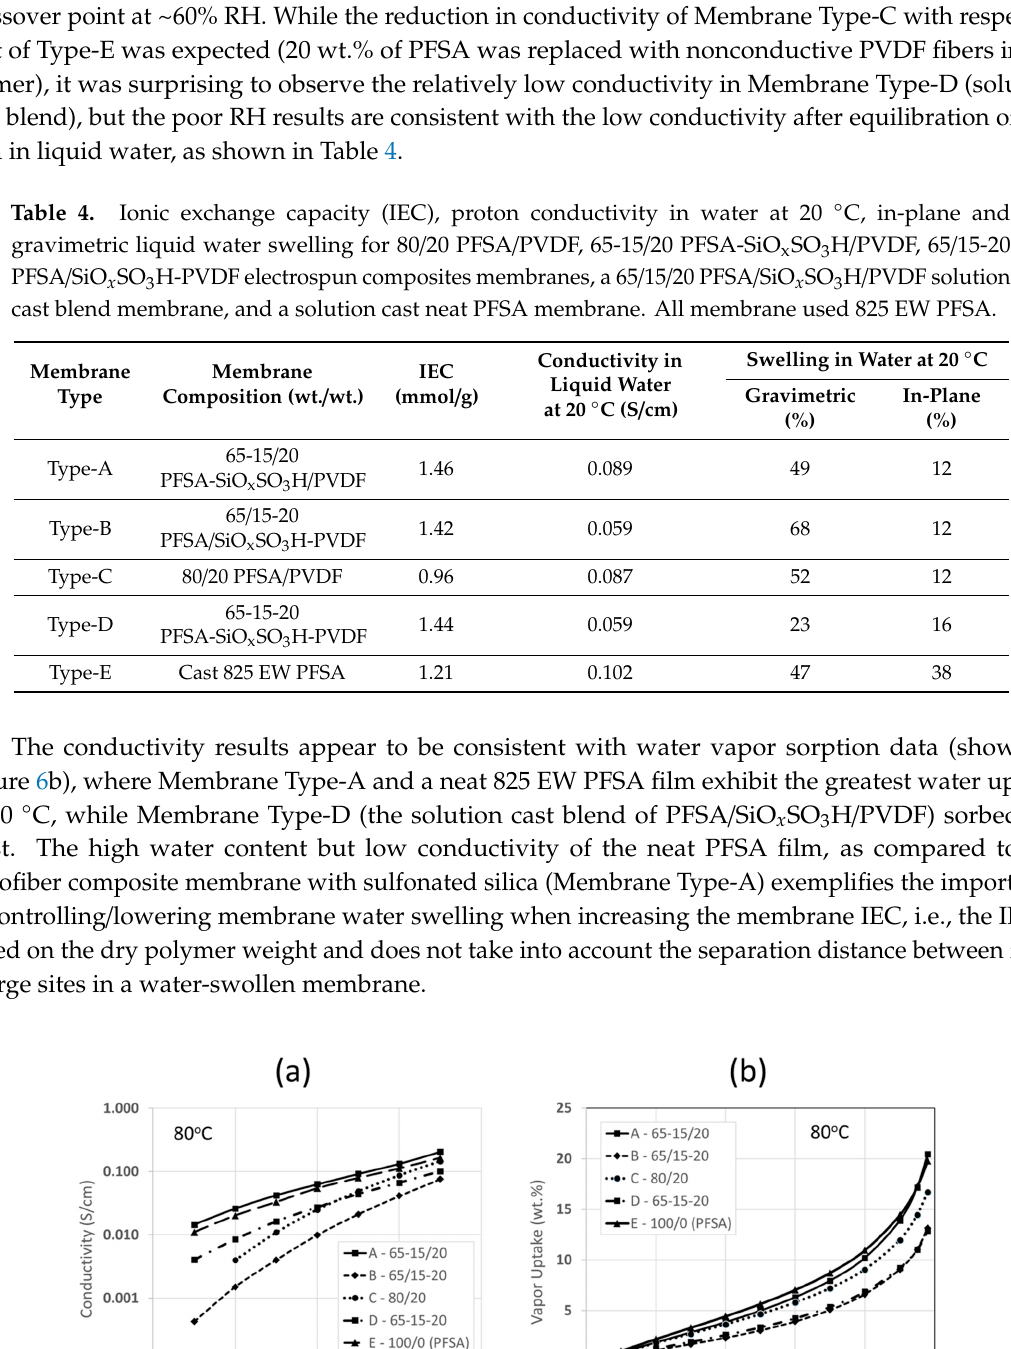
Table 4. Ionic exchange capacity (IEC), proton conductivity in water at 20 ◦ C, in-plane and